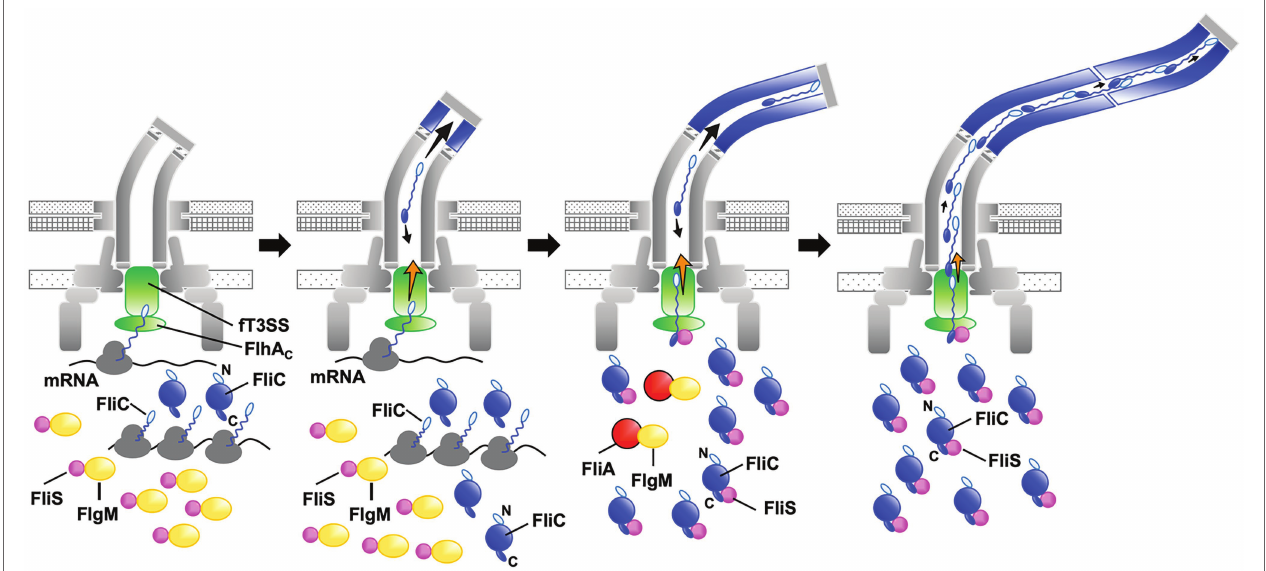
FIGURE 7 | Model for processive filament assembly at the hook tip. Flagellar filament assembly is composed of two distinct, FliS-independent and FliS-dependent processes. Upon completion of the hook structure, FlgM is secreted via the flagellar type III secretion system (fT3SS) into the culture media, thereby allowing FliA to act as a flagellum-specific sigma factor to drive the transcription of the fliC gene. As a result, a large amount of FliC is accumulated in the cytoplasm. FliC monomers are then unfolded and injected into the central channel of the flagellum by fT3SS one after another and transported to the distal end by diffusion to start forming the filament. Upon onset of this filament assembly, FliS binds to FlgM to inhibit FlgM secretion, and so FliC secretion and flagellar filament formation occur in a FliS- independent manner (left and left middle panels, steps 1 and 2). Then, FliS transfers FlgM to FliA to avoid the over-expression of FliC during filament assembly and becomes an export chaperone to assist FliC unfolding and export by fT3SS. FliS binds to the extreme C-terminal region of FliC with high affinity and facilitates FliC docking to the FlhA C ring. FliS also supports the fT3SS to efficiently unfold and inject FliC subunits into the central channel of the flagellum, which is followed by their diffusion down to the distal end of the growing structure where they assemble to form the filament (middle right, step 3). At the beginning of filament assembly, the distance from the fT3SS export gate to the assembly point is short, and the time for unfolded FliC monomers to reach the distal end is relatively short. The central channel may not be so crowded by FliC monomers, and therefore, the fT3SS export gate may not require such strong force to unfold and inject FliC into the central channel as it requires later when the filament becomes longer. FliS-assisted FliC unfolding would not be necessary in this stage when the filament is short (middle right, step 3). As the filament elongates, however, the diffusion time progressively increases, making the central channel very crowded (right, step 4). The fT3SS export gate now requires much stronger force for FliC unfolding and injection to continue filament growth, and FliS-assisted unfolding of FliC becomes essential in this later stage of filament assembly. That is why FliS deletion stops filament growth at relatively short